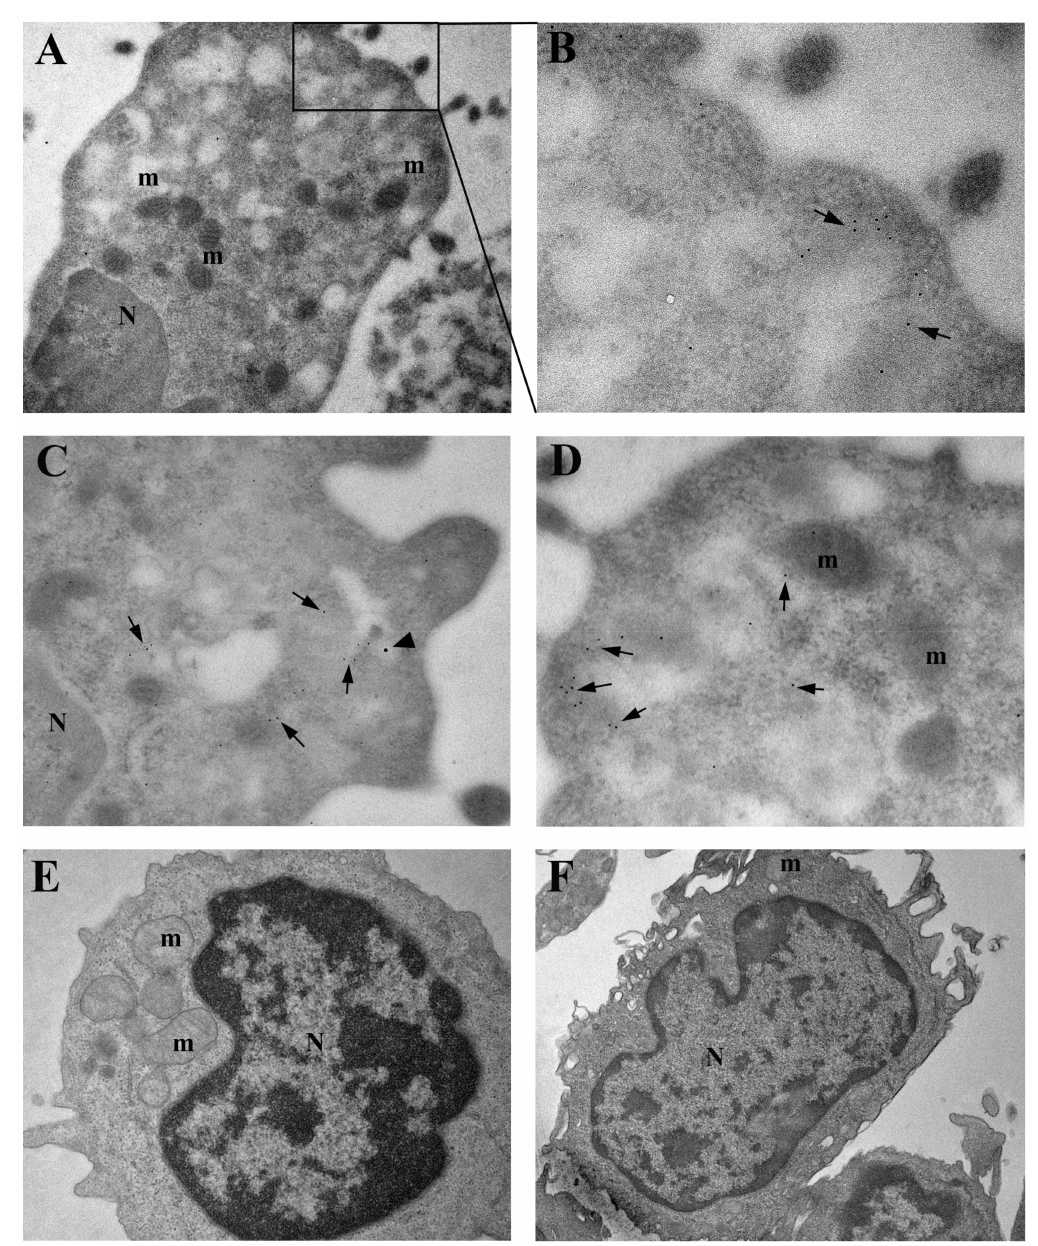
Figure 4. Immuno-electron microscopy and ultrastructural analysis of PBMC from HIV-1-infected NP patients. ( A , D ) PBMC from 5 NP (Patients No. 2, 9, 10, 12, and 15) were subjected to immunogold analysis. A double immunolabeling was performed, utilizing anti-TRIM5 α (15 nm gold particles, arrowheads) and anti-HIV-1 Nef (5 nm gold particles, arrows) antibodies. ( A ) Numerous 5 nm gold particles (arrows) labeling HIV-1 Nef are present in vacuole-enriched areas of the cytoplasm of a macrophage. ( B ) Magnification of the boxed area in A. ( C , D ) Arrowheads indicate that TRIM5 α immunolabelling is present in the cytoplasm. Ultrastructural morphology of a lymphocyte ( E ) and of a macrophage ( F ) from HIV-1-infected NP patients. N, nucleus; m, mitochondria. Original magnifications: A, 15,000 × ; B–D, 50,000 × ; E, 20,000 × ; F, 12,000 ×